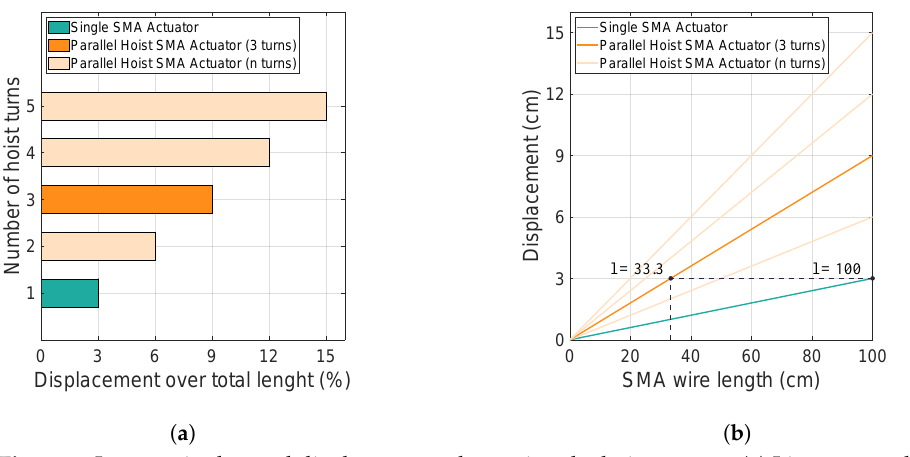
Figure 2. Increase in the total displacement when using the hoist system. ( a ) Linear growth of the displacement percentage. ( b ) The same displacement wire